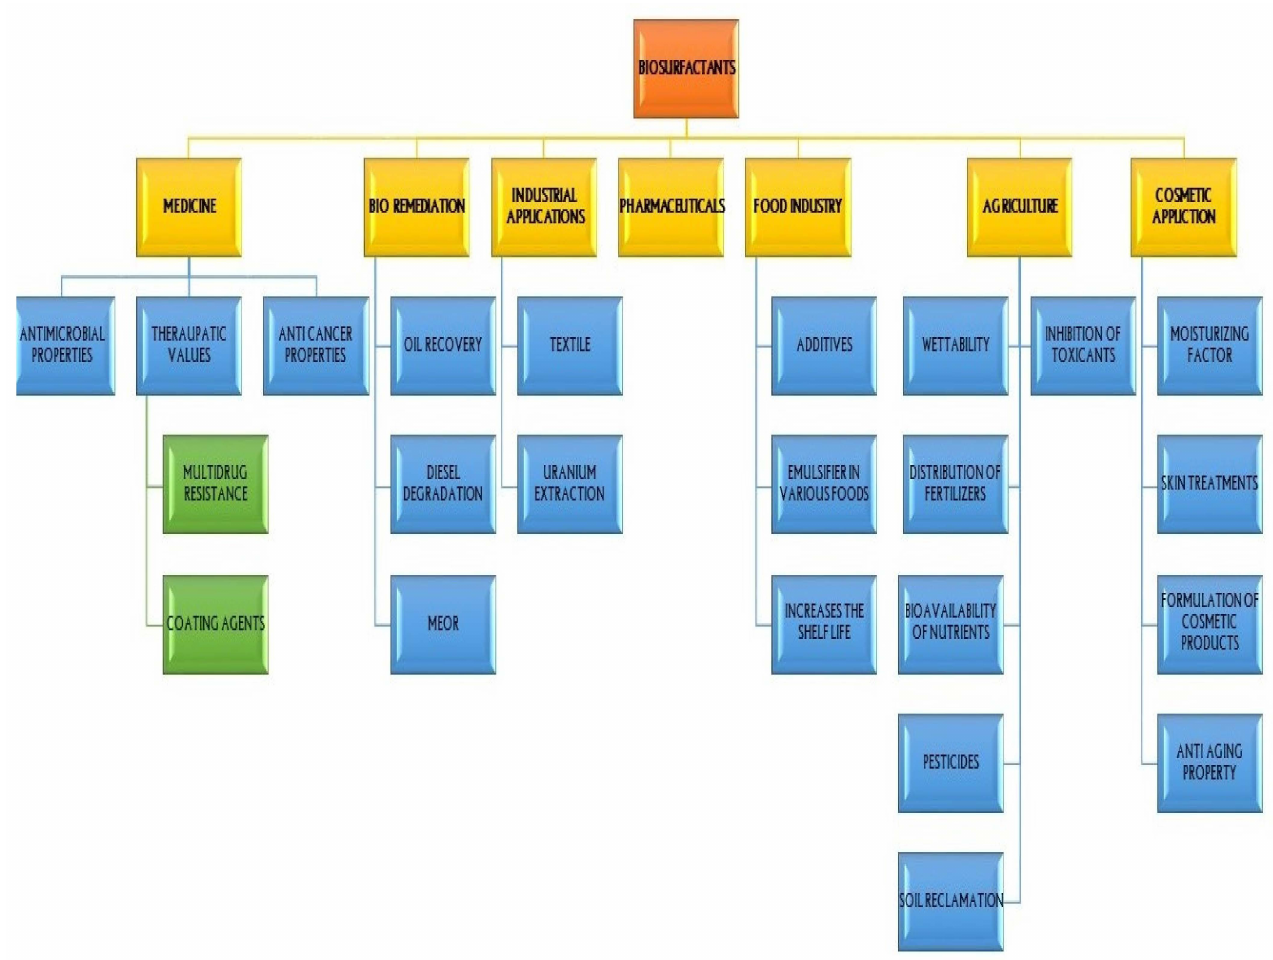
Figure 9. Application of biosurfactant in various